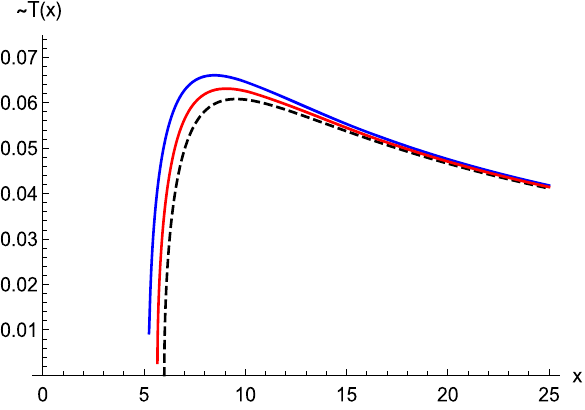
Fig. 9 Dependence of the ISCO radius on the parameter a ∗ for a Fig. 8 Radial profiles of the temperature per unit accretion rate of a Kerr black hole (green curve) and on the parameter ˜ ξ for the RGI- thin accretion disk around a RGI-Schwarzschild black hole for ˜ ξ = ˜ ξ Schwarzschild black hole (blue = 16 / 27 (blue) and ˜ ξ = 0 . 3 (red). The dashed line corresponds to c the temperature of the disk around a Schwarzschild black hole in GR ( ˜ ξ = 0) Table 2 The specific energy at ˜ ξ k isco the ISCO and the efficiency (cid:11) of the conversion of the accreted mass into radiation for several values of ˜ ξ